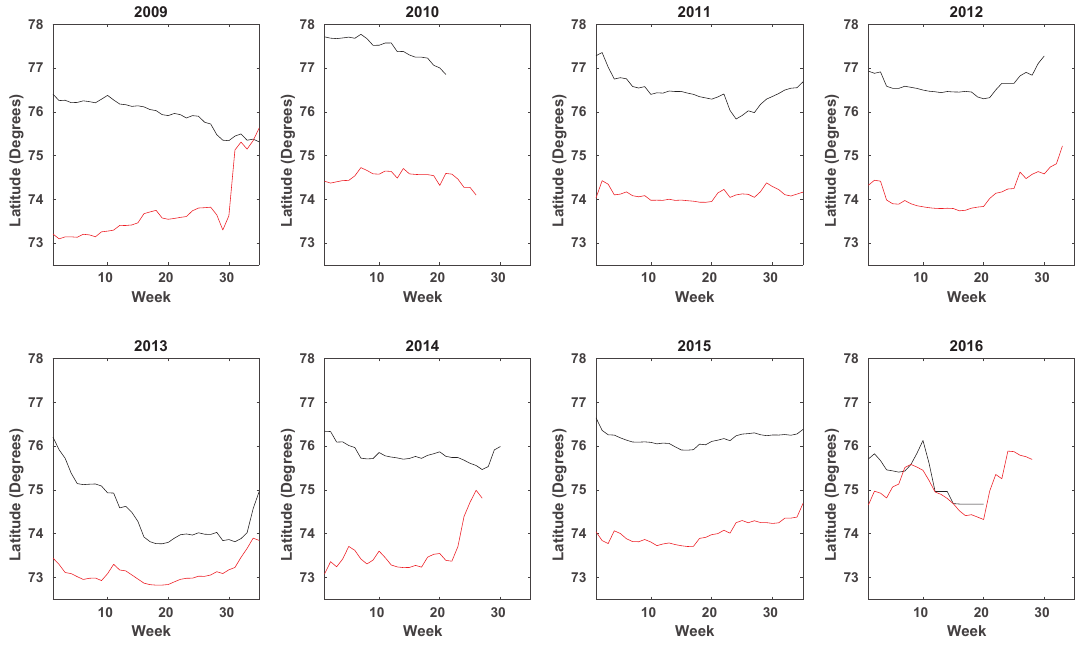
Figure 7. Mean latitudes of sea ice parcel populations during 2009–2016. Melted parcels are shown in red , surviving parcels are shown in black .